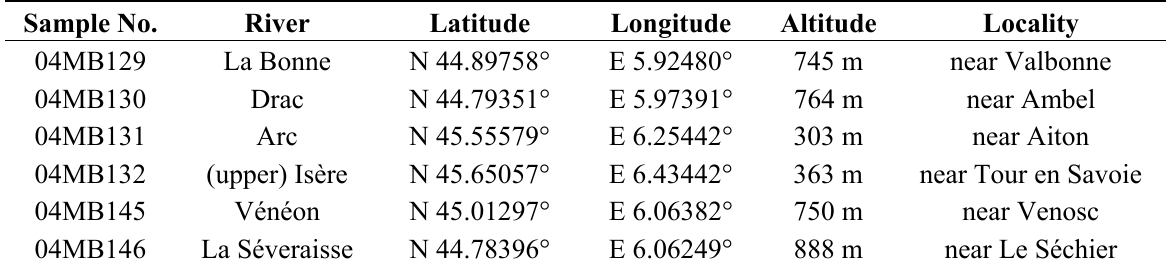
Table 1. Isère drainage system river sample locations for zircon fission-track analysis. Sample